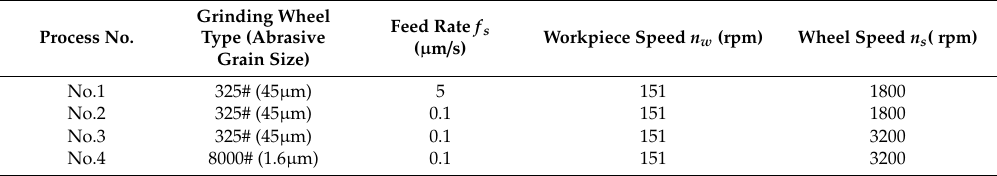
Table 1. Grinding conditions used in